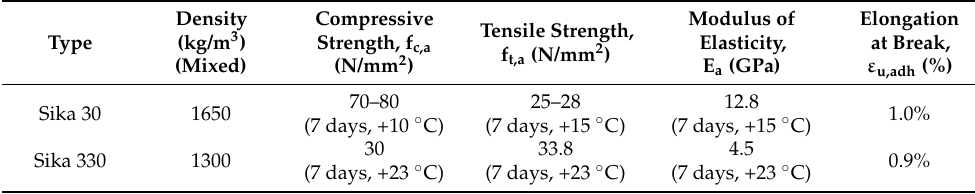
Table 3. Properties of the adhesives